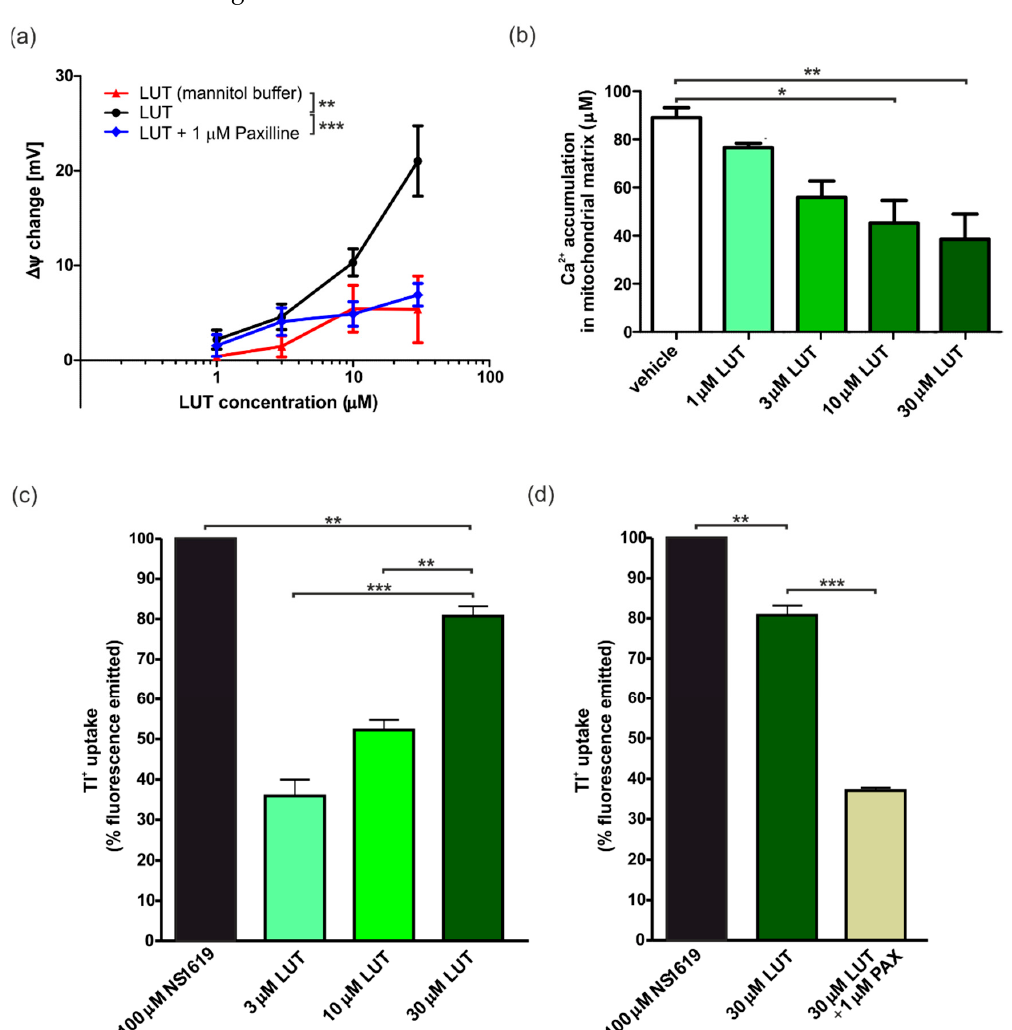
Figure 2 . Ex vivo determination of mitoBK Ca channels activation properties by LUT. ( a ) Changes in ΔΨ in the presence of LUT . The increasing mitochondrial depolarization is shown for LUT 1, 3, 10 and 30 μ M. The blue line corresponding to results obtained in conditions where 1 μ M paxilline were added 2 min before LUT and the red line to results obtained for LUT in mannitol buffer (potassium- free) for the same flavonoid concentrations. The level of statistical significance between these two conditions was determined by one-way ANOVA with Tukey’s test for n = 3 ( p < 0.01 (**); p < 0.001 (***)). ( b ) Impact of LUT on calcium ions accumulation in the cardiac mitochondrial matrix . The graph shows the μ M concentration of calcium uptaken by mitochondria in probes with 1, 3, 10 and 30 μ M LUT and with vehicle (0.3% DMSO; the maximum concentration of the vehicle used). The level of statistical significance in comparison to 0.3% DMSO was determined by one-way ANOVA with Tukey’s test for n = 3 ( p < 0.05 (*), p < 0.01 (**)). ( c ) Changes of K + flux in the presence of LUT measured by Tl + fluorescent probe . Graph shows the % fluorescence emitted vs. 100 μ M NS1619 (100%) as maximal mitoBK Ca channel activation and for 3, 10 and 30 μ M LUT. The level of statistical significance was determined using one-way ANOVA with Tukey’s test for n = 4 ( p < 0.01 (**), p < 0.001 (***)). ( d ) Inhibition of mitoBK Ca channels by paxilline measured by Tl + fluorescent probe . Graph shows the activation of the channel by 30 μ M LUT vs. NS1719 and its inhibition in probe 30 μ M LUT with 1 μ M paxilline (PAX). The level of statistical significance was determined using one- way ANOVA with Tukey’s test for n = 4 ( p < 0.01 (**), p < 0.001 (***)).